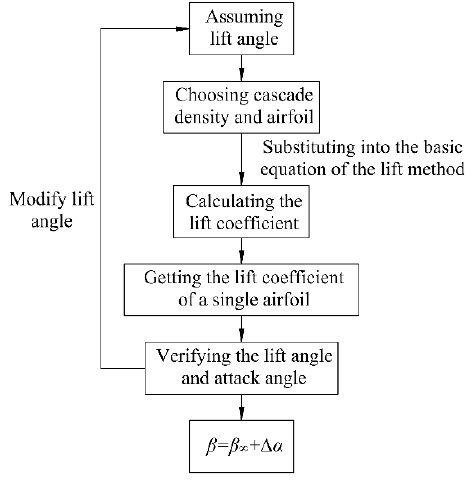
Figure 4. Flowchart of rotor design by lifting design method.